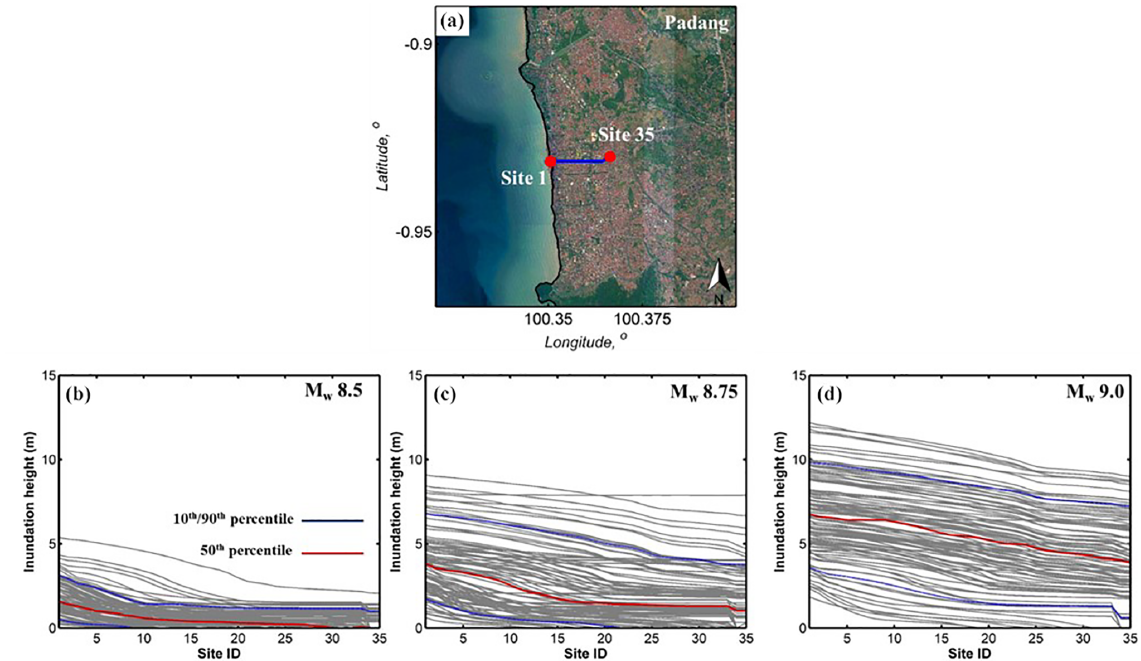
Figure 12. (a) Site location. (b) Maximum tsunami inundation height in the second river of Padang for the M w 8.5 scenario. (c) Maximum tsunami inundation height in the second river of Padang for the M w 8.75 scenario. (d) Maximum tsunami inundation height in the second river of Padang for the M w 9.0 scenario.